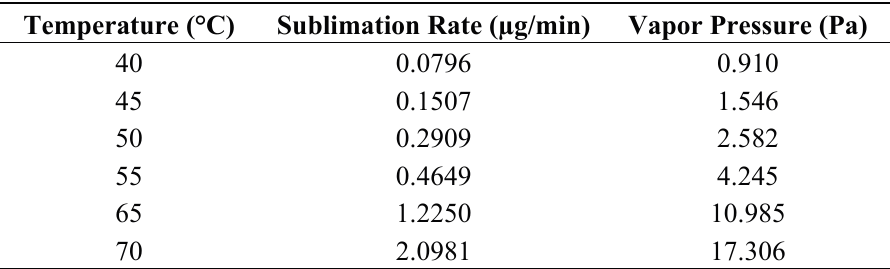
Table 2. Experimental sublimation rate obtained using the TGA system and reported vapor pressure of benzoic acid in the temperature range from 40 to 70